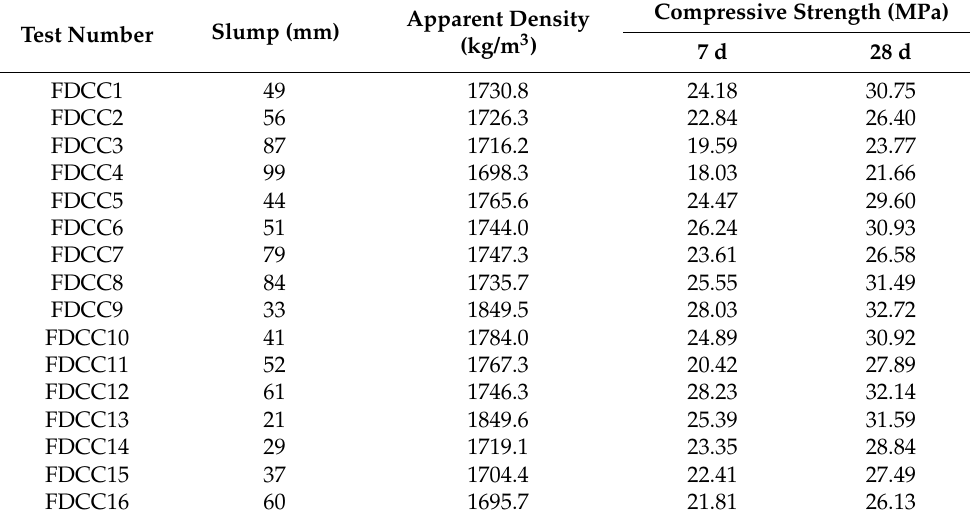
Table 7. The orthogonal test